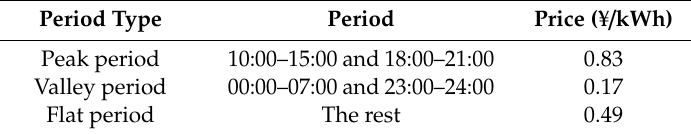
Table 4. Time-of-use (TOU) power